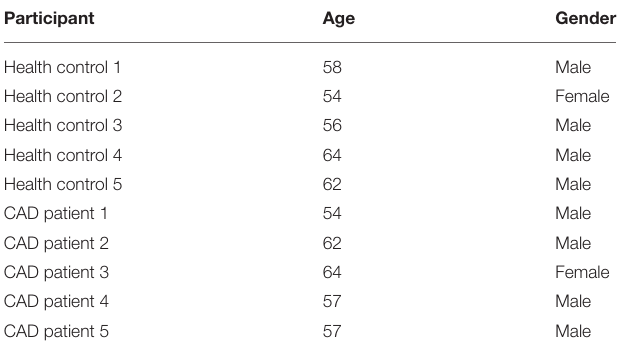
TABLE 1 | The information of clinical sample